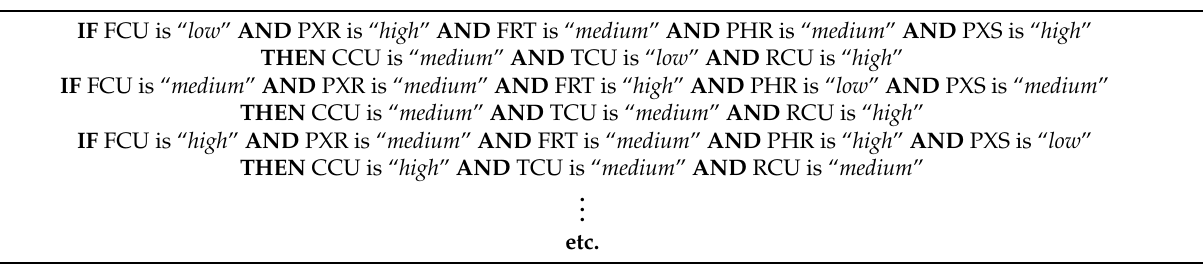
Table 7. Fuzzy rules